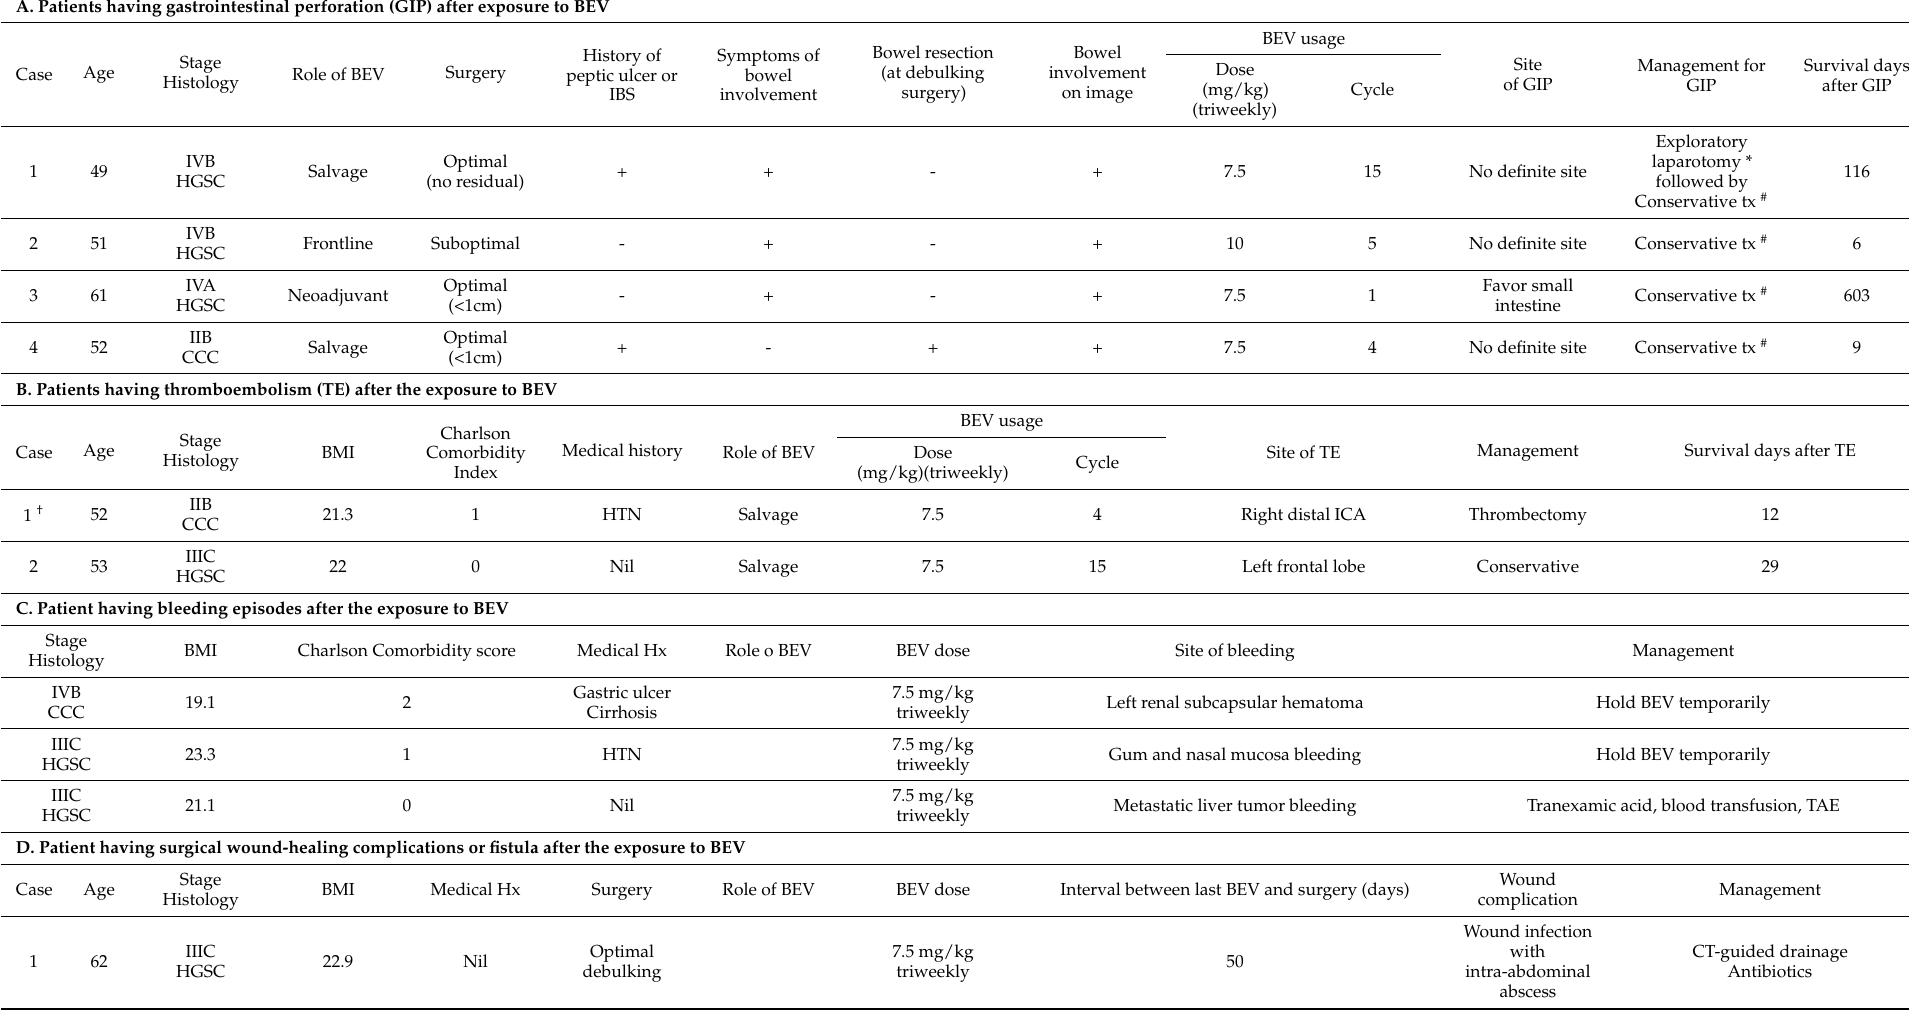
Table 4. Patients having adverse events after exposure to bevacizumab